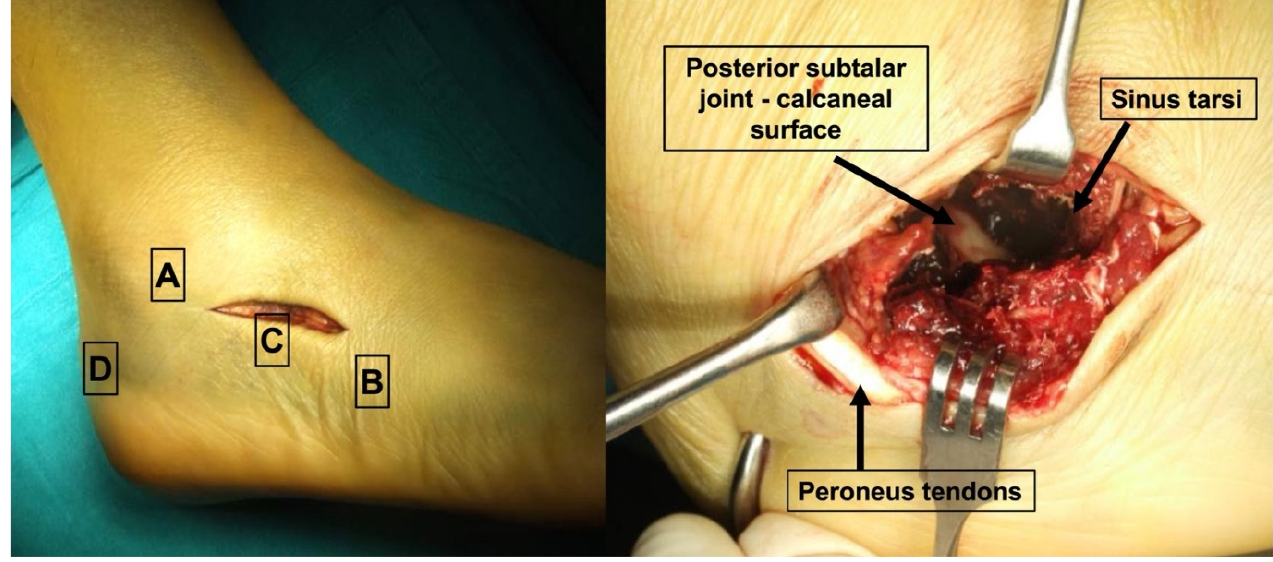
Figure 1. Mini-open posterior subtalar approach. On the left, ( A ) lateral malleolus apex, ( B ) cuboid bone, ( C ) sinus tarsi, ( D ) posterior calcaneal tuberosity.